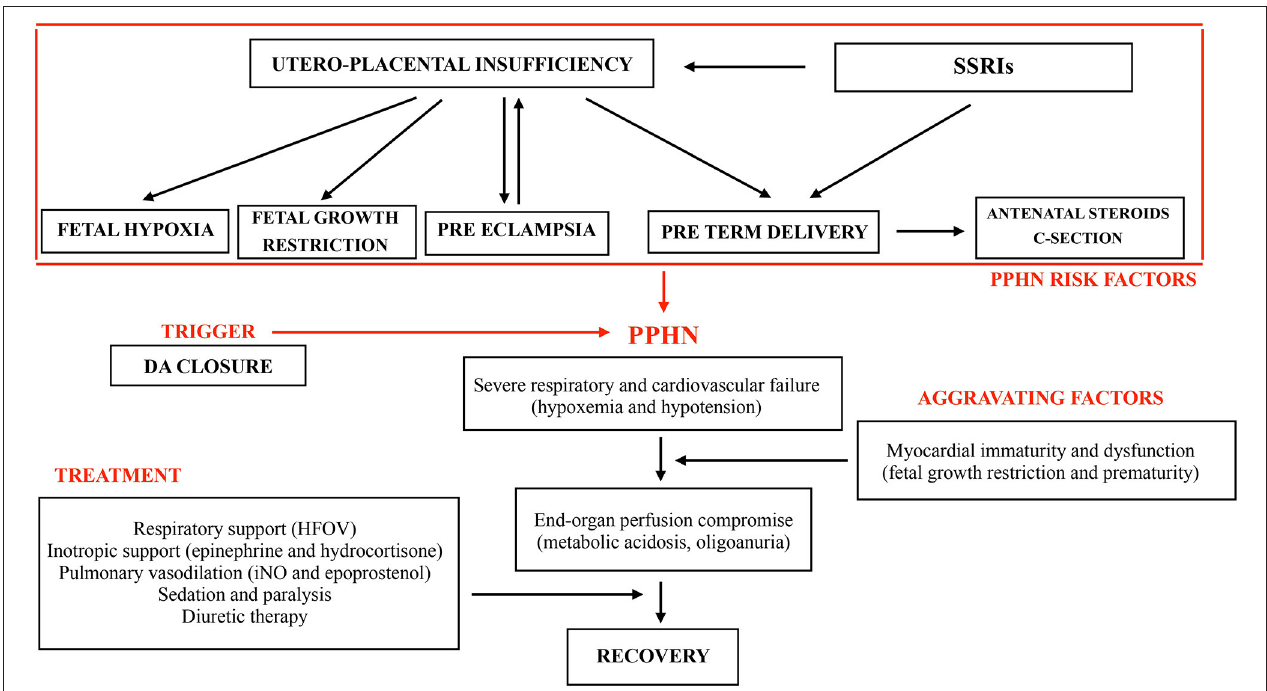
FIGURE 1 | Physiopatological factors of PPHN, clinical course and interventions.